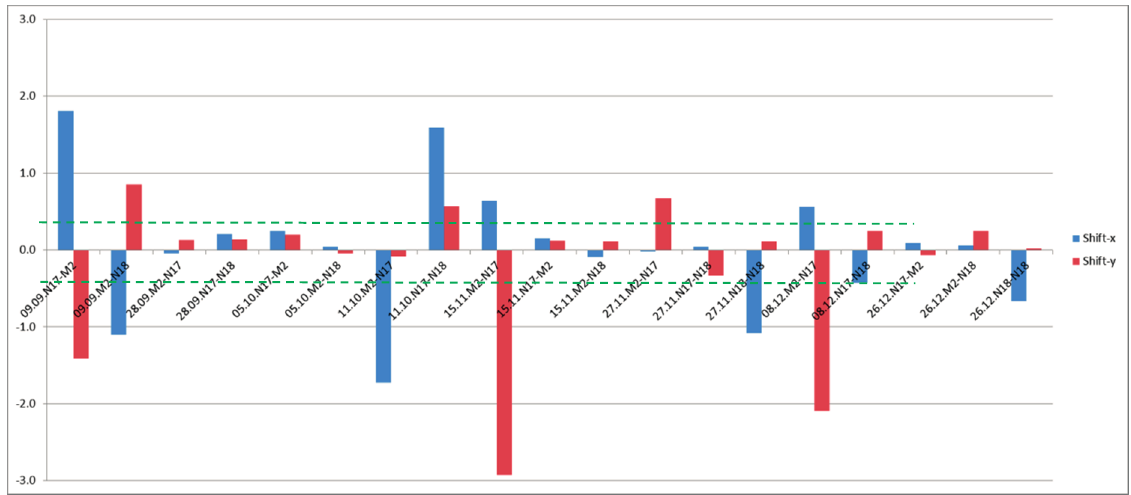
Figure 8. The mean x-, y-shifts obtained from 19 image pairs obtained from Metop-A, NOAA-17 and NOAA-18 between September and December 2008. Horizontal axis: Time, Vertical axis: